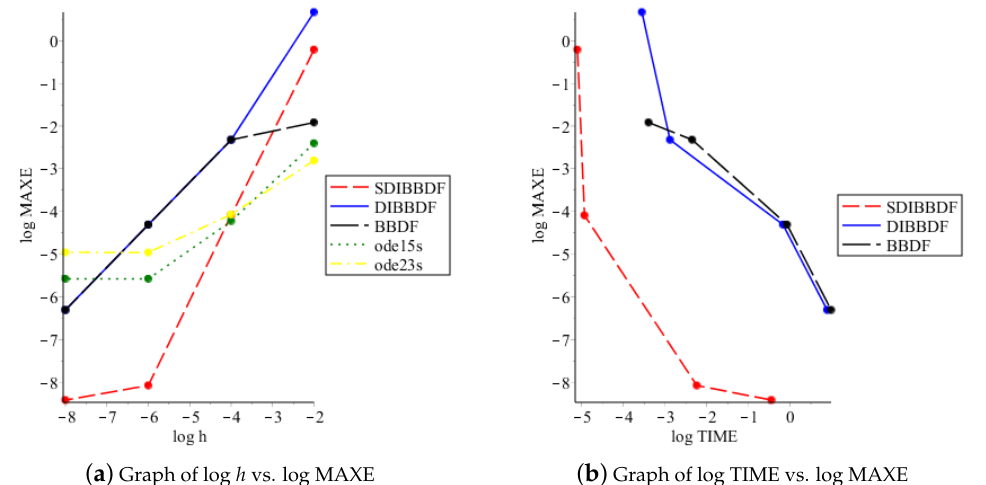
Figure 7. Efficiency curves for test problem 3.